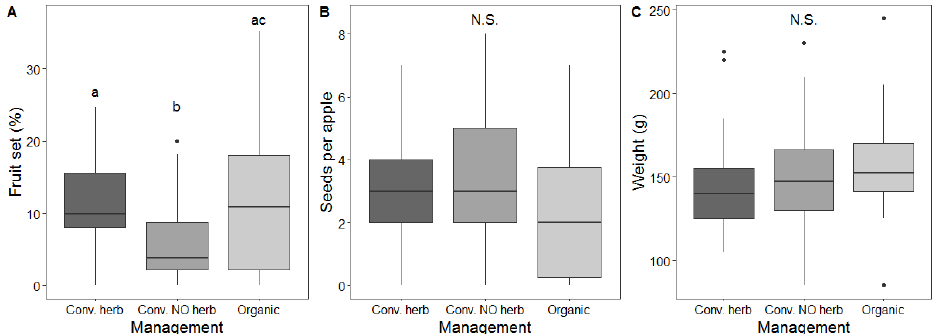
Figure 5. ( A ) Fruit set (number of fruits per flower in each branch) according to management system; ( B ) Seed set (number of seeds per fruit) in different orchards ( n =30 per orchard); ( C ) Weight of apples ( n =30) according to management system. N.S. denotes non-significant effects, and different letters represent significant effects between levels. The black horizontal line is the median, the box is defined by the 25th and 75th percentiles (lower and upper quartile) and the whiskers are 1.5 the interquartile range. Data beyond the end of the whiskers plotted individually are outlier points.